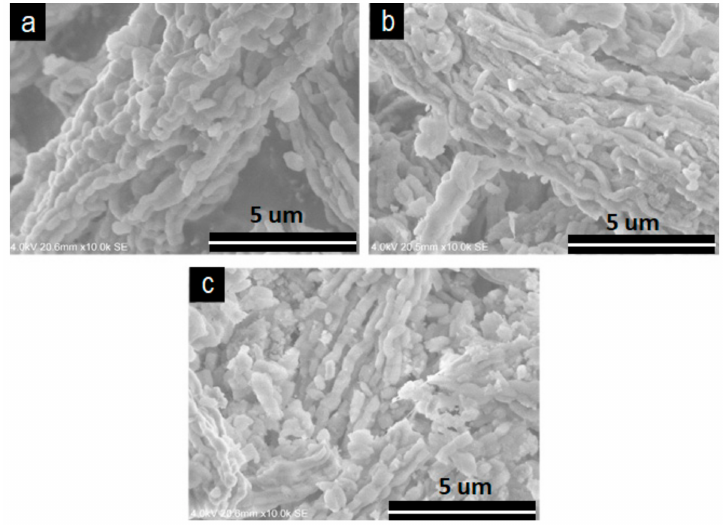
Figure 4. SEM images of V 2 O 5 /Zr-SBA-15. ( A ) 10V/Zr-SBA-15; ( B ) 20V/Zr-SBA-15; ( C ) 30V/Zr-